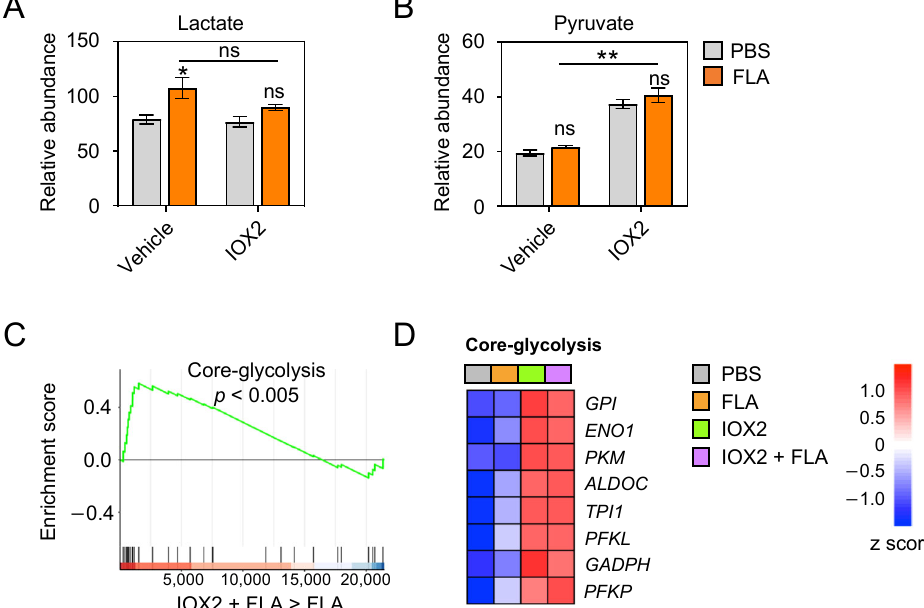
Figure 2. IOX2 induces glycolysis and accumulation of pyruvate in HBE cells ( A ) Relative abundance of lactate analyzed via liquid chromatography–high resolution mass spectrometry (LC-HRMS) in HBE cells pre-treated for 1 h with IOX2 (50 µ M) or vehicle and stimulated for 24 h with PBS or flagellin. ( B ) Relative abundance of pyruvate as in ( A ). ( C ) Gene set enrichment analysis (GSEA) of the core glycolysis pathway in HBE cells activated with flagellin for 24 h in the presence of either vehicle or 50 µ M IOX2 (pre-treated for 1 h). The x axis shows individual genes, and the y axis shows enrichment score. Red represents upregulated genes and blue represents downregulated genes. ( D ) Heat map of changes in the expression of the core glycolysis pathway genes in the indi ‐ cated conditions. Data in ( A , B ) are presented as mean ± SEM ( n = 3–4 replicates per group). p value was calculated using Student’s t test. * p < 0.05; ** p < 0,01; ns, not significant. Data in ( C , D ) comprise 3 biological donors with 1–2 replicates from 2 independent experiments ( n = 5).